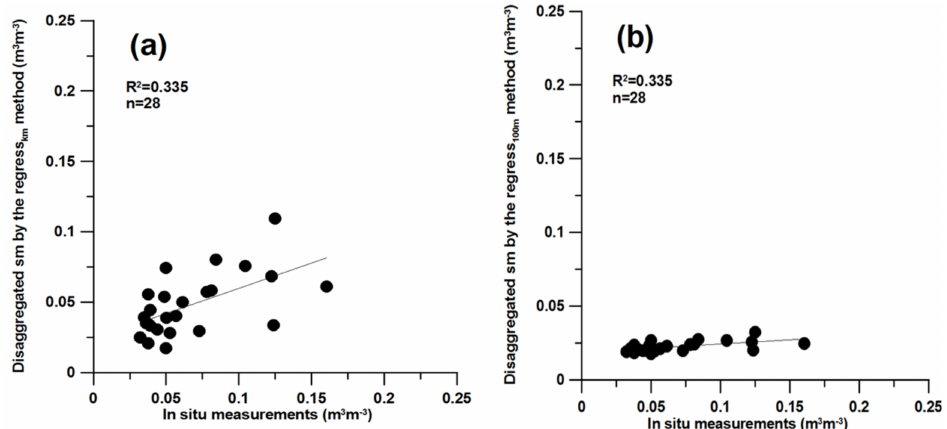
Figure 7. Evaluation of disaggregated soil moisture products by: ( a ) the regress km ; and ( b ) the regress 100m against the in situ measurements.